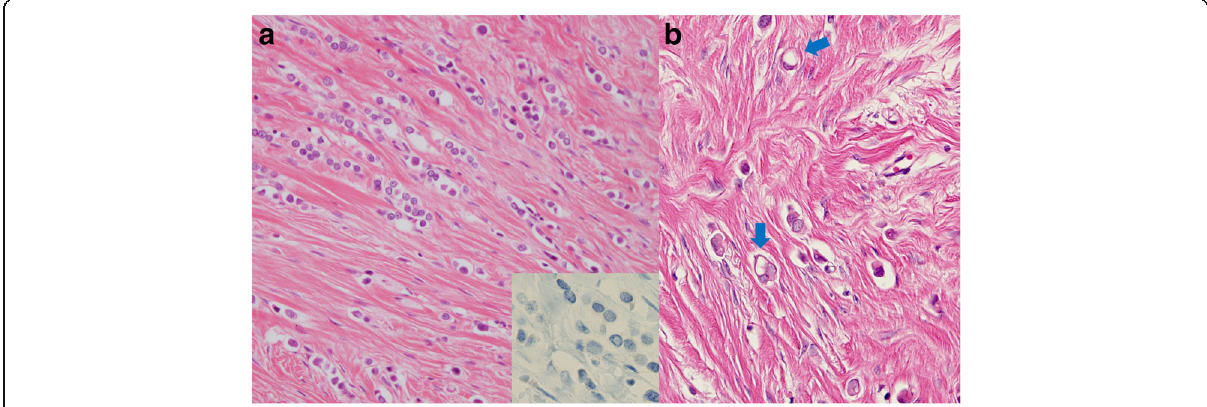
Fig. 1 Pathological findings of primary breast cancer. a Invasive lobular carcinoma in primary breast lesion: discohesive small round cells (E-cadherin negative) are arranged in slender strands (Hematoxylin and eosin staining (HE), ×400). b Signet-ring cell features (blue arrows) were observed in the invasive lobular carcinoma lesion of the primary breast cancer